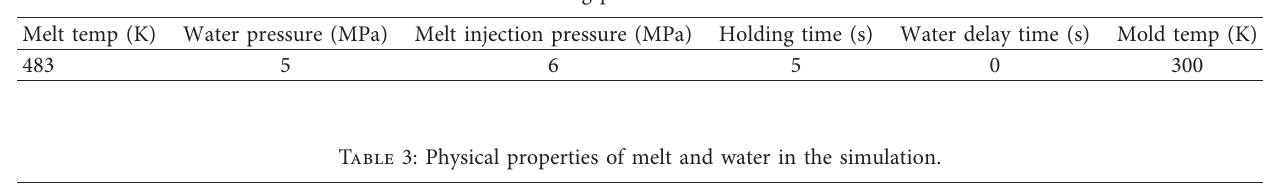
Figure 2: Projectile used in the simulation of W-PAIM process (All dimensions are in millimeters). Table 2: Processing parameters in the simulation.